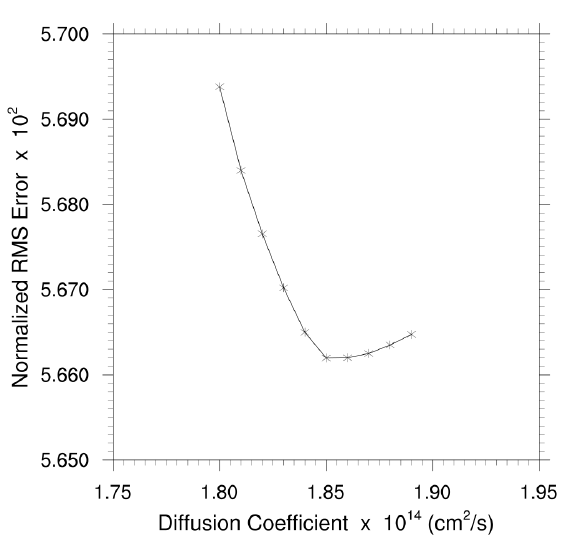
Figure 7. RMS Error for the case of Room